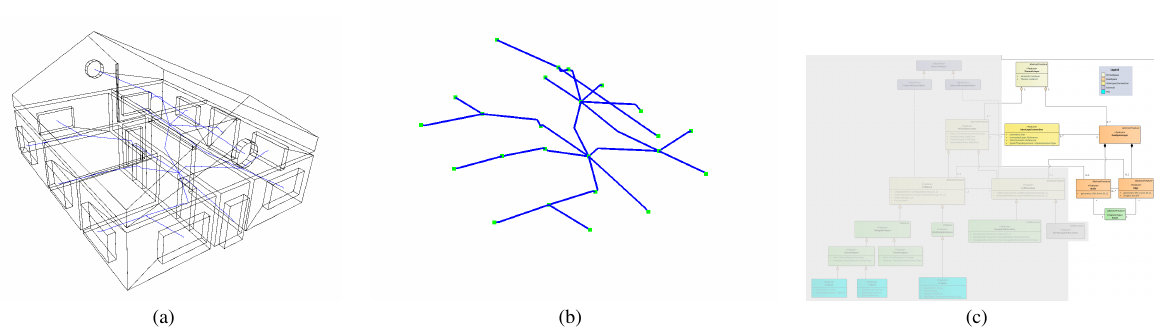
Figure 8. Storage of topological information only. (a) Ifc entities and their computed adjacency graph. (b) Network to store in IndoorGML. (c) Part of the UML required for topology (network)